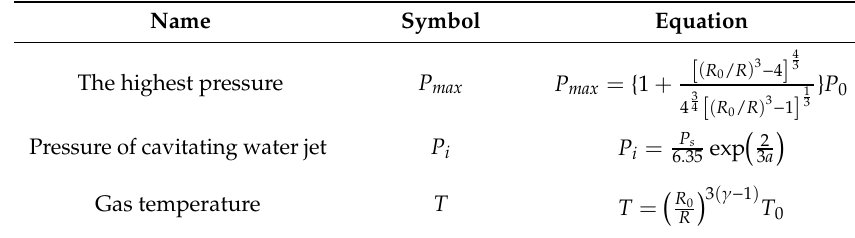
Table 1. Some key energy equations of the bubble bursting.